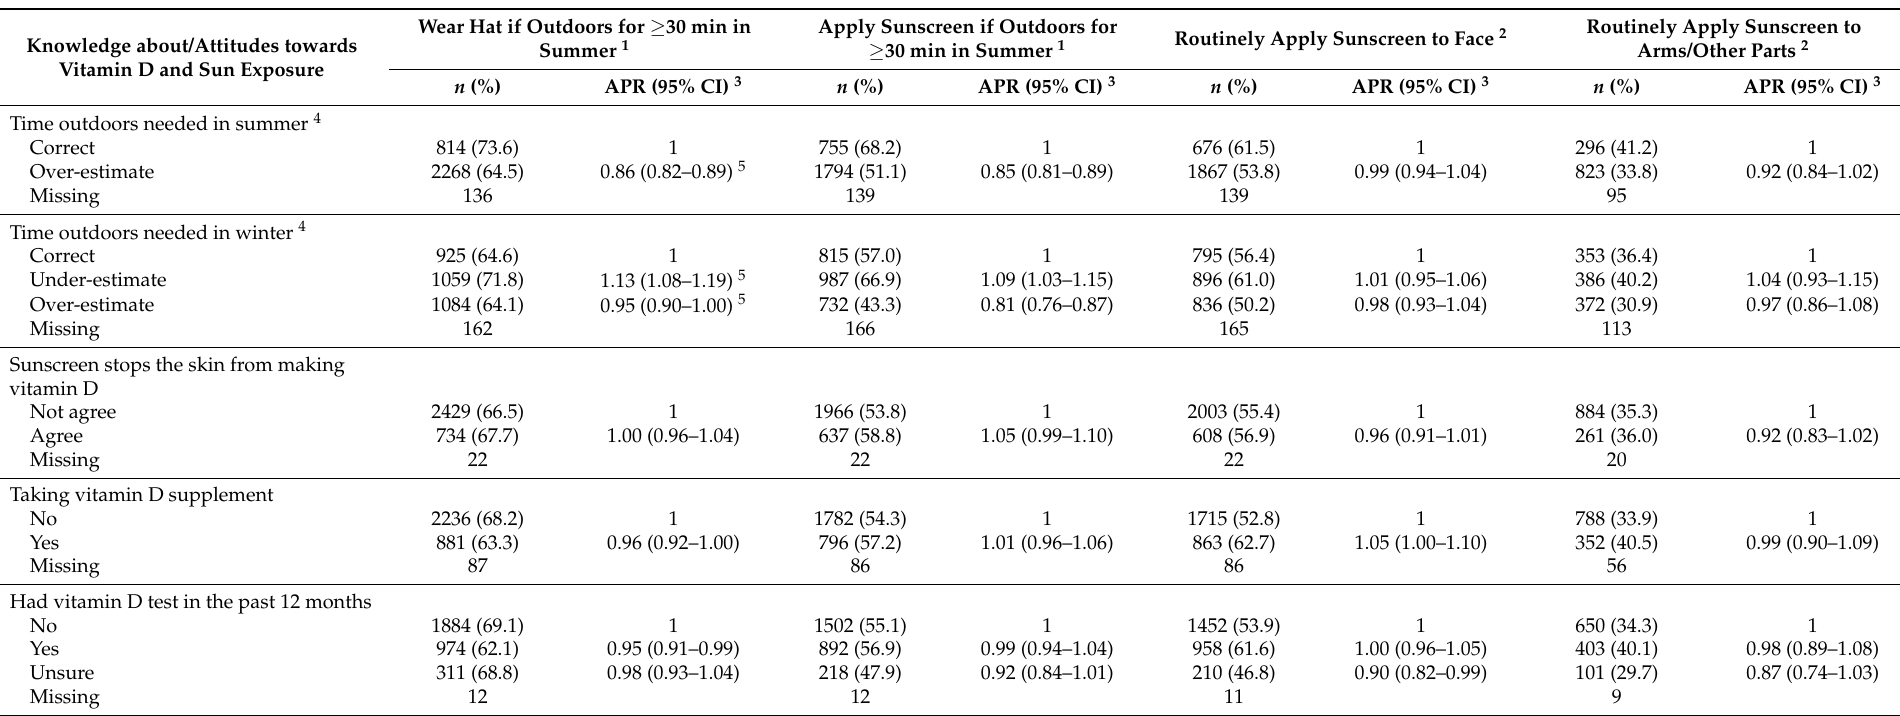
Table 4. Associations between knowledge about/attitudes towards vitamin D/sun exposure and sun protection